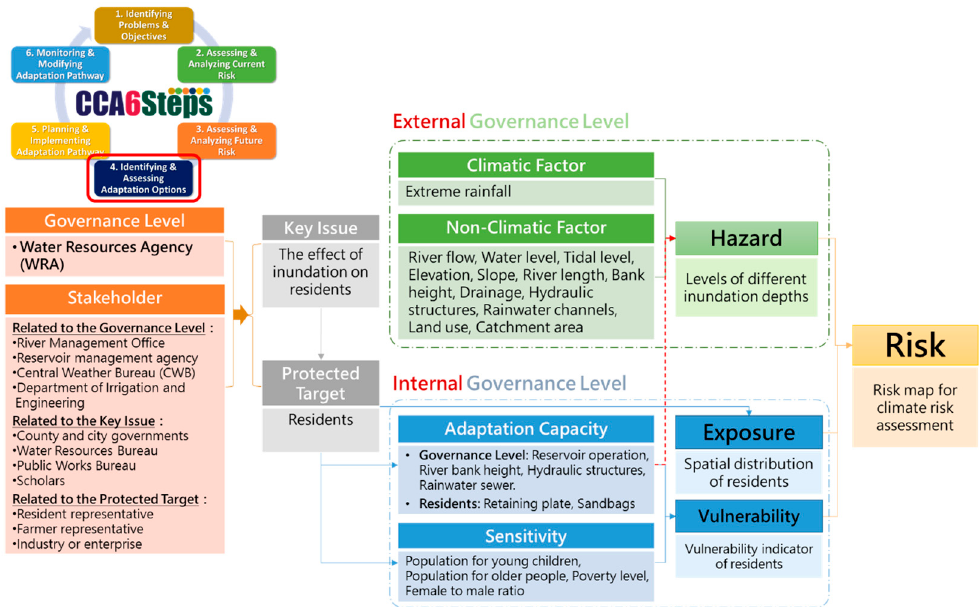
Figure 10. The proposed algorithm of climate risk assessment for investigating the relationship between factors based on Step 4 of CCA6Steps.